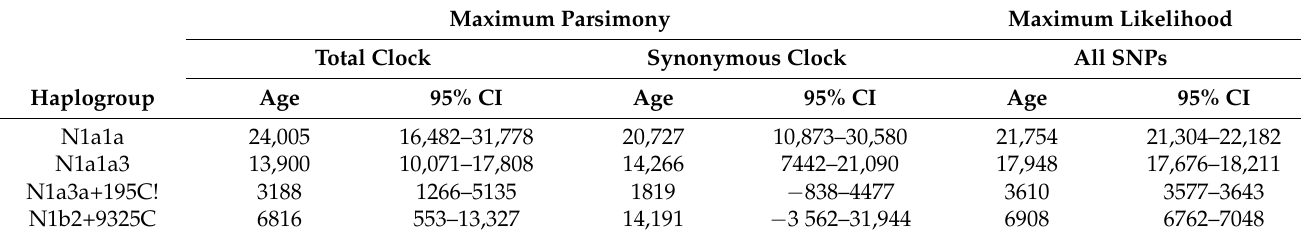
Table 2. Age estimates and standard deviations (in years) for N1a haplogroups in Africa. Maximum Parsimony Maximum Likelihood Synonymous